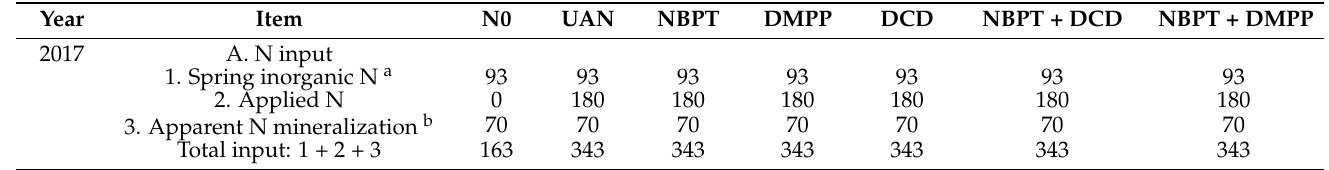
Table 2. Nitrogen budgets (kg ha − 1 ) in 2017 and